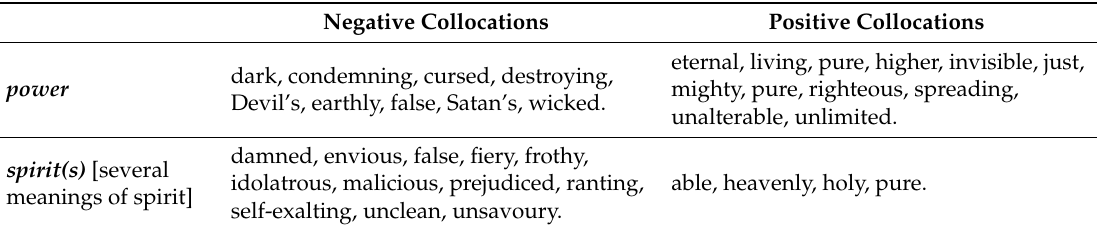
Table 3. Results of search queries of collocations relating to the items power and spirit(s). Negative Collocations Positive